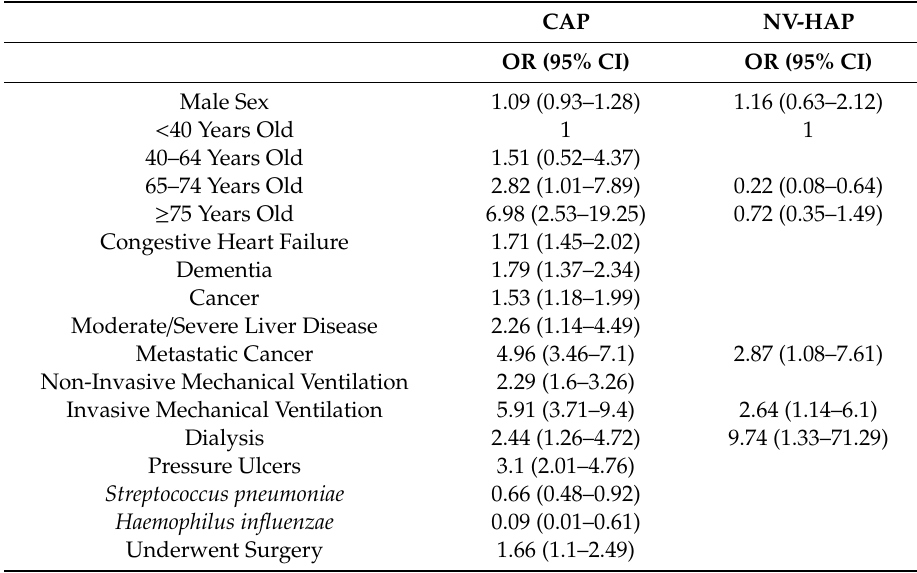
Table 4. Multivariable analysis of factors associated with in-hospital mortality during admissions for community-acquired pneumonia (CAP) and non-ventilator hospital-acquired pneumonia (NV-HAP) among patients with